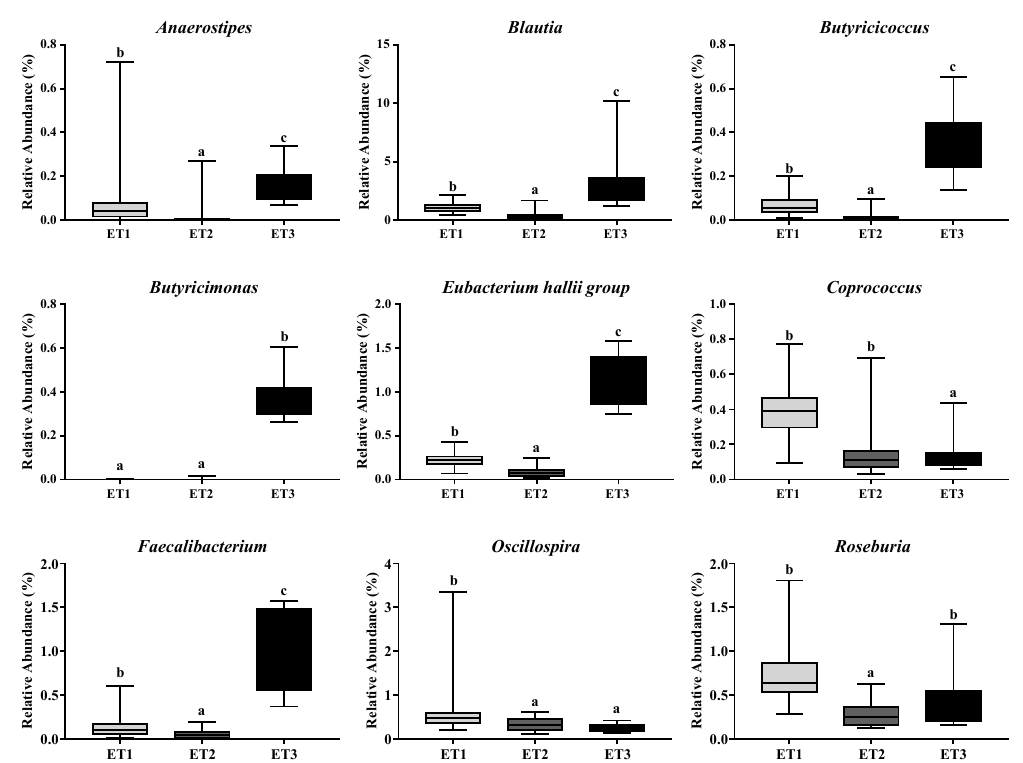
Figure 6. Differentially abundant butyrate-producing bacterial genera in three enterotypes. The relative abundances of the nine most abundant genera related to butyrate production in three ETs were illustrated. Different letters indicate a significant difference ( p < 0.05) with the 95% confidence interval. Abbreviation: ET, enterotype.